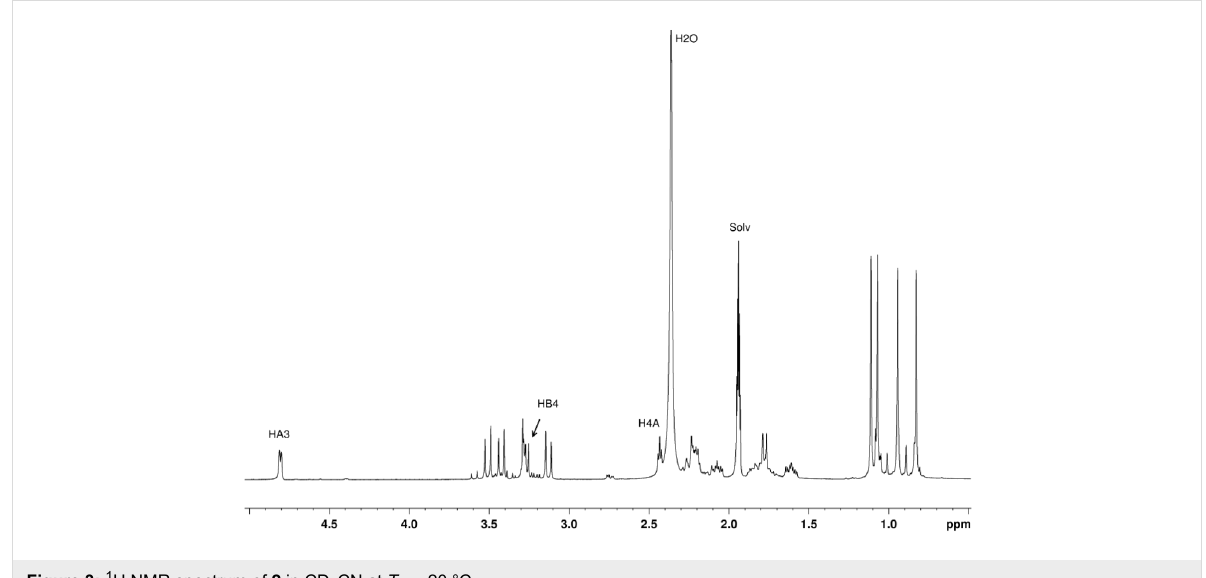
Figure 3: 1 H NMR spectrum of 2 in CD 3 CN at T = − 20 °C.